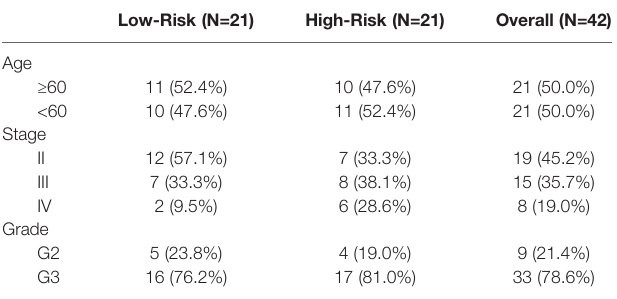
TABLE 2 | Clinical features of the clinical